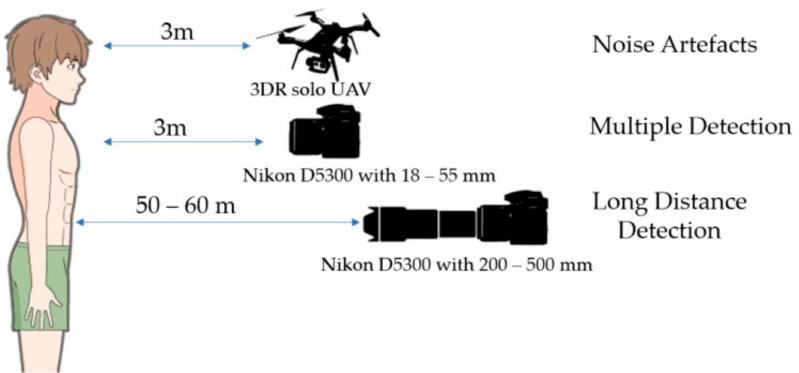
Figure 10. The experimental setup and data acquisition of the noise artefact removal, multiple person and long detection system